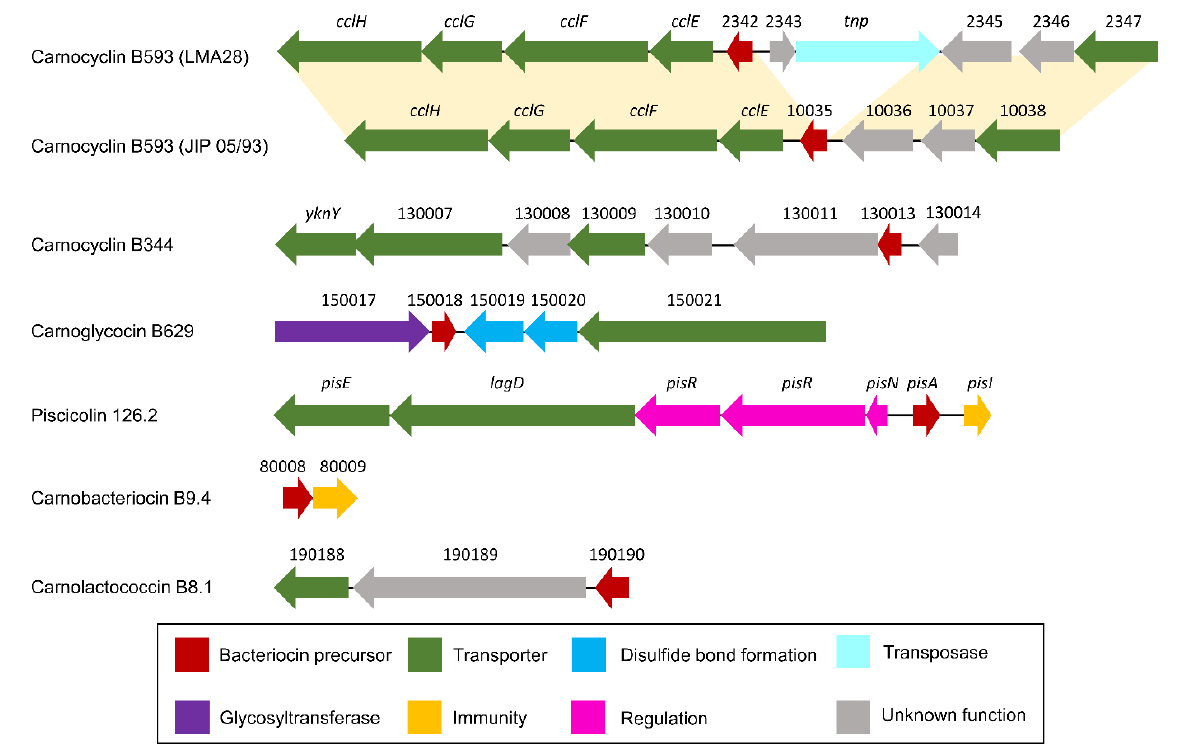
Figure 6. Schematic representation of bacteriocin BGCs. Below the arrows which represent CDSs, the short names of the locus tags are indicated (the prefix have been omitted: “BN424_”, “CMALT398_v1_”, “CMDSM20344_v1_”, “CMALT430_v1_”, “CMALT94_v1_”, “CMALT81_v1_” for LMA28, JIP 05/93, DSM20344, 10040100629, 9.4, and 8.1, respectively). The yellow shading connects homologous regions between BGCs.